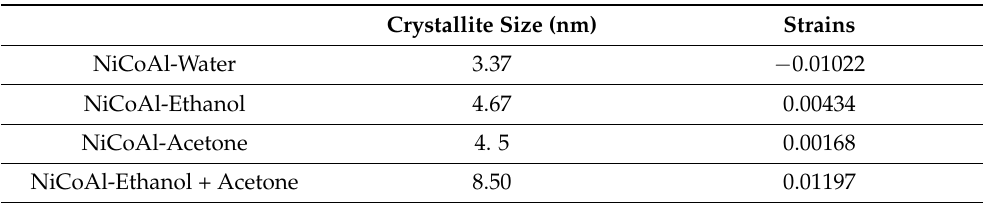
Table 2. Calculated values of crystallite sizes and extracted strain values for NiCoAl-Water, NiCoAl- Ethanol, NiCoAl-Acetone, and NiCoAl-Ethanol + Acetone.